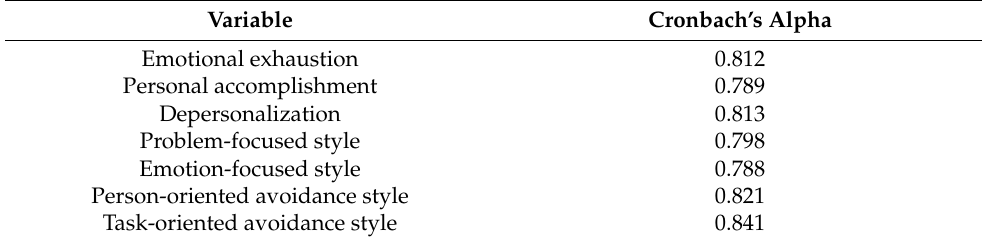
Table 2. The Cronbach’s alpha index.